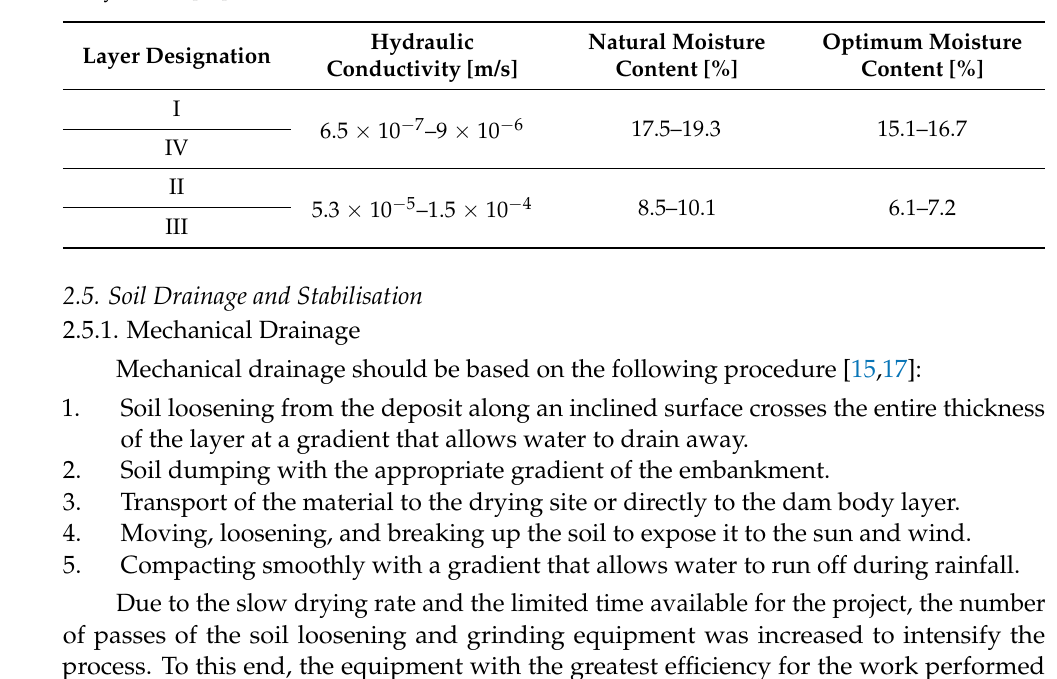
Table 4. Ranges of natural and optimum moisture content of individual soils and hydraulic conduc- tivity values [43].